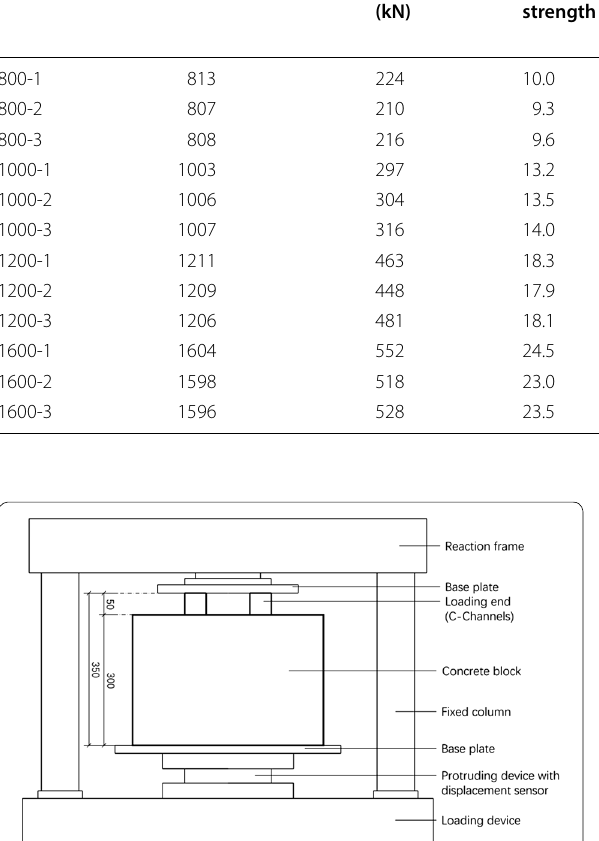
Table 2 Properties of foam concrete. Test block no.